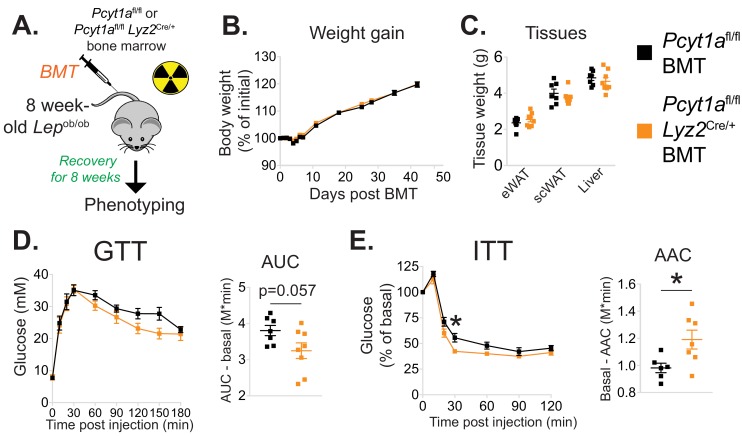
Myeloid cell-specific deletion of Pcyt1a leads to improved systemic glucose metabolism on the Lepob/ob genetic background.(A) Schema of the BMT study design. (B) Body weight gain curves and (C) weights of indicated tissues of Lepob/ob mice transplanted with Pcyt1afl/fl (n = 7) or Pcyt1afl/fl
Lyz2Cre/+ (n = 8) bone marrow. (D)GTT curves and areas under curve (AUC), normalised to basal glucose levels. (E) ITT curves, presented as percentage values of basal glucose levels, and areas above curve (AAC), normalised to basal glucose levels.